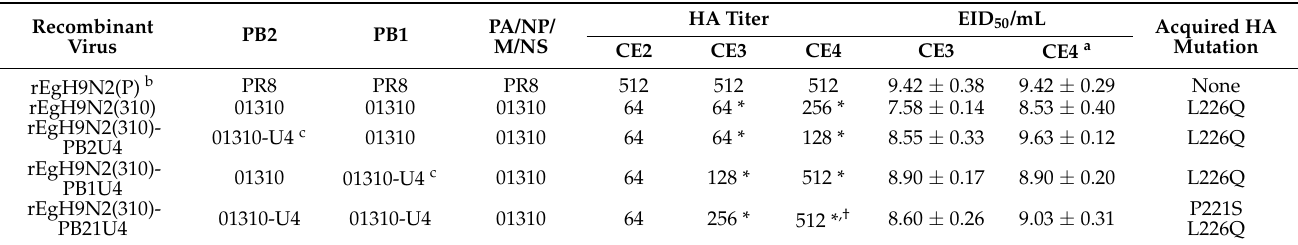
Figure 1. E . coli toxic ORF in the HA2 subunit gene and hotspots of deletion mutations. MF434468.1 was identical to the A/chicken/Egypt/ME543V/2016 (H9N2) (ME543), and synthetic H9 genes had a single nucleotide deletion (~) in four different positions of the hot spot (A at 1336, C at 1350, C at 1359 or A at 1365), forming a stop codon and terminating HA protein synthesis early. They encode the leucine-rich sequence (ELLVLL) and are mutated into the same nucleotide sequence of 01310 without amino acid change. Additionally, the Shine–Dalgarno sequence (GAGG) prior to the toxic ORF was eliminated by mutation into GAAG to reduce the expression. * means the stop codon and red box was site described with the text above it. Table 1. Genomic compositions and virus titers of recombinant Egyptian H9N2